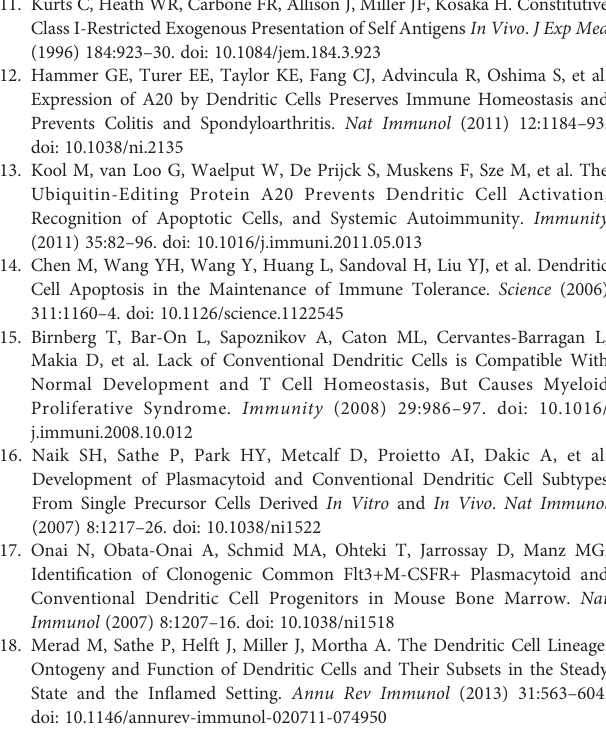
Supplementary Figure 2 | Characterization of CD8a+ cDC1s and pDCs (A) CD8a vs CD11b staining of gated CD11c+ MHC-II+ splenic cDCs in WT and CBL-/-CBL- B-/- mice. The experiment was repeated for more than three times. (B) Expression of costimulatory ligands on CD8a+ cDC1s and CD11b+ cDC2s. The experiment was repeated for more than three times. (C, D) FACS analysis of the bone marrow (BM) andsplenic(SP)pDCs. ShownarePDCA-1vsCD11cstainingofBM andspleencells (C) andstatistics (D) .(n=5).(E)qPCRanalysisofCXCR4andCCR5expressioninWT and CBL-/-CBL-B-/- pDCs. (n = 3). Data are means ± SEM of at least fi ve mice or three independent experiments. *p < 0.01; **p < 0.001. Supplementary Figure 3 | Gene and protein expression pro fi les in WT and CBL-/-CBL-B-/- cDC1s and cDC2s (A) Heatmap analysis of the chemokines, cytokines and genes related to DC development and function. Data represent pooled RNA samples from 6x WT and 6x CBL-/-CBL-B-/- mice. (B) qPCR analysis of TNF-a, IL-6 and CCL2 expression in WT and CBL-/-CBL-B-/- CD8a+ cDC1s. Shown are fold increases of the corresponding gene transcripts in the mutant cells relative to WT cells. (n = 3). Data are means ± SEM of at least three independent experiments. *p < 0.01. (C) Western blot analyses of IRF4 and IRF8 in WT and CBL-/-CBL-B-/- CD24hi cDCs. Supplementary Figure 4 | Pathological analyses of CBL-/-CBL-B-/- mice and RAG1.CBL tko mice (A) H&E staining of lung and kidney sections of WT and sick CBL-/-CBL-B-/- mice. Data are from one of fi ve mice. (B) Serum cytokine and chemokine titers. Shown are dot blot hybridization of serum cytokine and chemokine titers of pooled serum samples from WT RAG1-/- and sick RAG1.CBL tko mice. (n = 3). (C) Total numbers of in fl ammatory cell subsets in liver in fi ltrating leukocytes of RAG1-/- and sick RAG1.CBL tko mice. (n = 5). Data are means ± SEM of at least fi ve mice. *p < 0.01; **p < 0.001. Supplementary Figure 5 | Flow cytometric analysis of cDC subsets in and lifespananalysisofMyD88.CBLtkomice (A) FACSanalysis(left)andstatistics(right) of cDCsand CD8a+ cDC1s and CD11b+ cDC2s in WT(C57BL/6 orMyD88-/-) and MyD88.CBL tko mice. (n = 6). (B) Kaplan Meier survival analysis of WT (MyD88-/-), CBL-/-CBL-B-/- and MyD88.CBL tko mice. (n=10). Data are mean ± SEM of two independent experiments. *P < 0.01; **p <